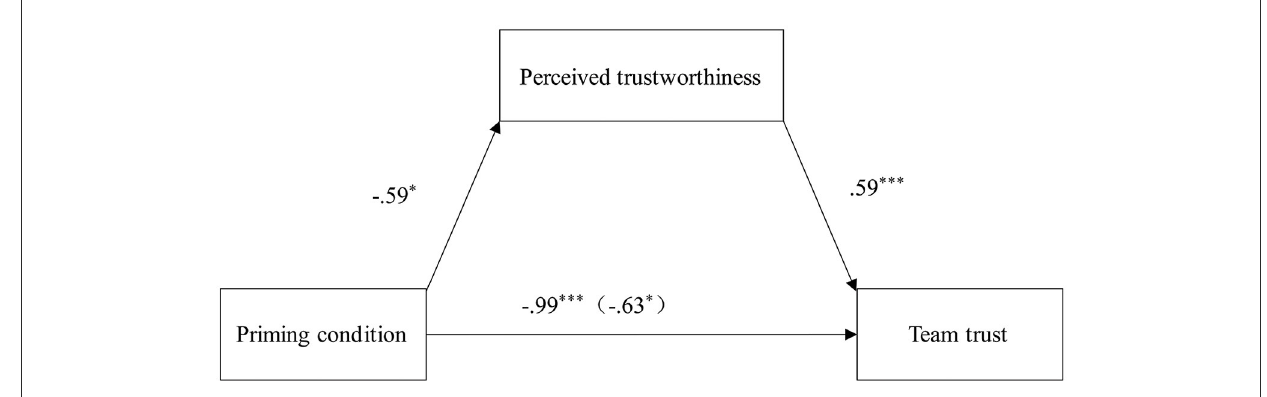
FIGURE2 Illustration of the mediation effect. * p < 0.05, *** p <